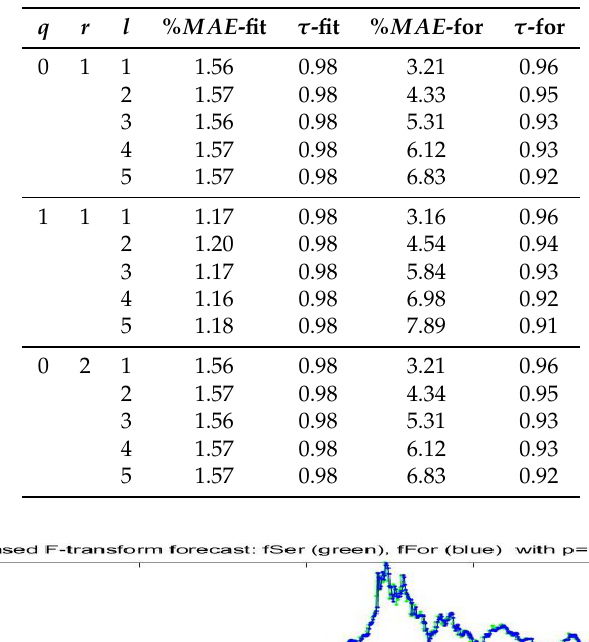
Table 5. Model B: L p -norm Fitting and Forecasting results For p = 1.5, the table shows indices % MAE and Kendall τ correlation for the fitting (columns 4,5 with label fit ) and the forecasting (columns 6,7 with label for ) corresponding to five lags l ∈ { 1,2,3,4,5 } and three pairs of order q and bandwidth r .